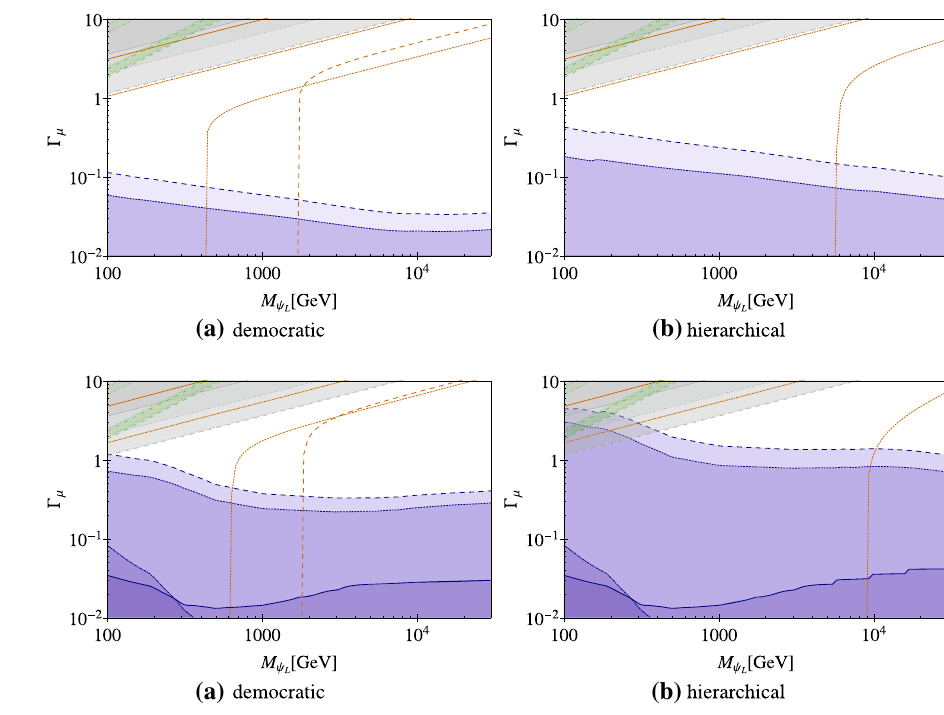
Fig. 7 Summary plot for Dirac DM in bVA. The legend and an explanation of the color scheme are given in Fig.4